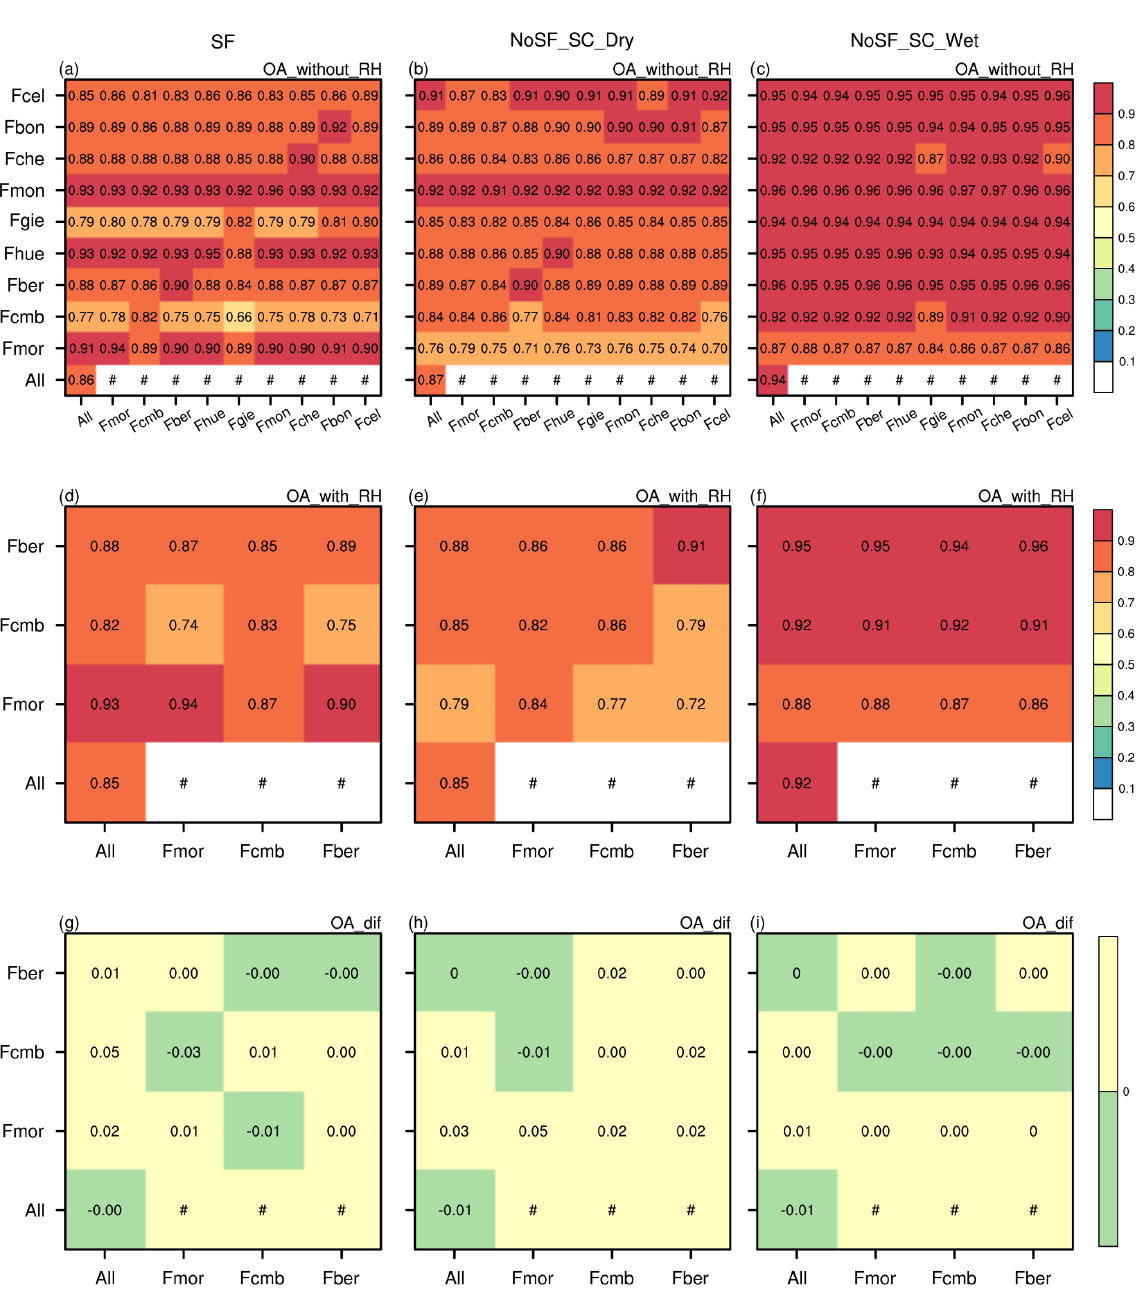
Figure 4. The overall accuracy (OA) of the SIDTM and SSDTMs trained without (a–c) and with (d–f) RH, and their difference (g–i) in SF, No_SF_DRY and No_SF_WET conditions, respectively. The x axis represents the SIDTM and SSDTMs constructed based on 80% of corresponding observations, and the y axis represents the validation